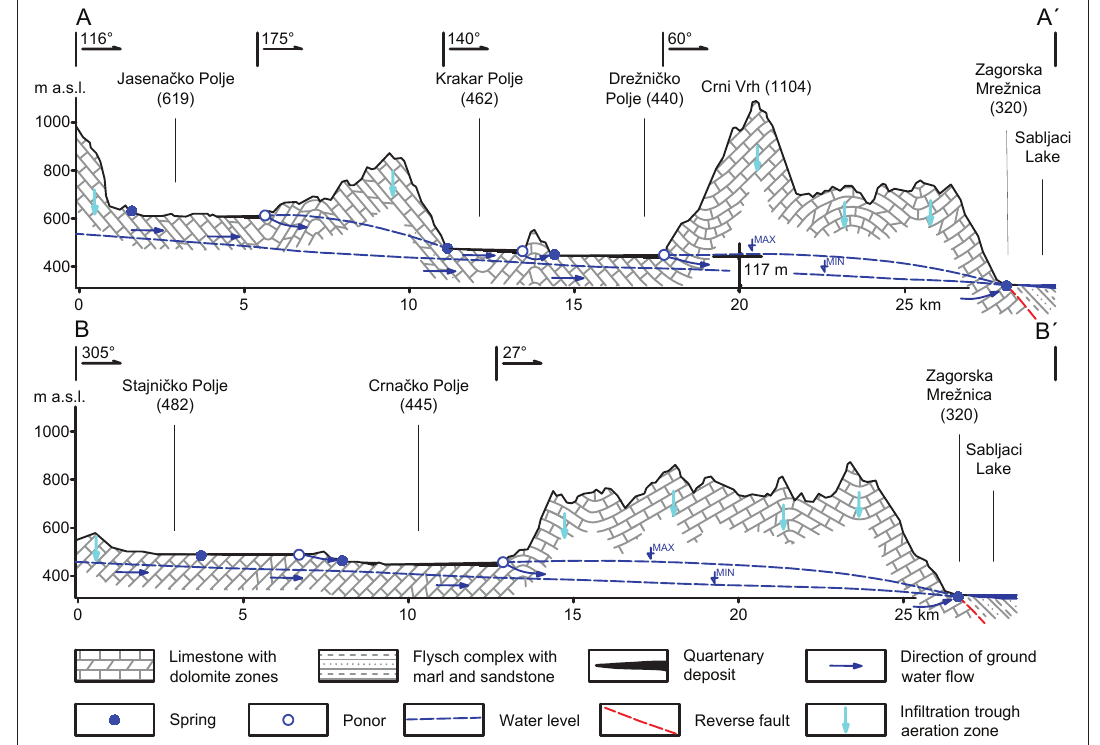
Figure 2. Cross-section profiles through the research area (locations shown in Figure 3) with schematized hydrogeological